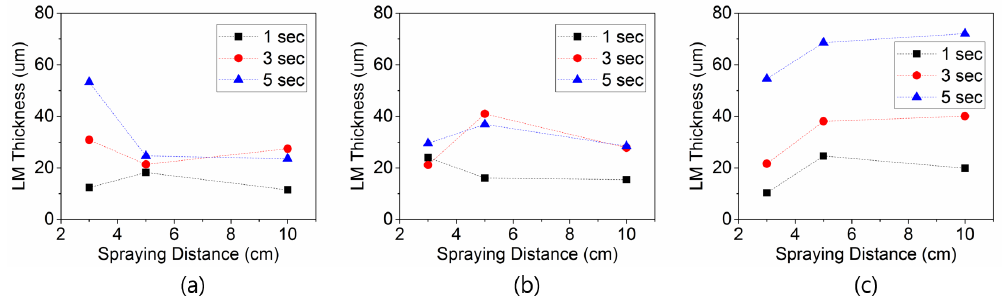
Figure 3. Characterization of sprayed LM line thickness when sprayed onto a substrate 3 cm, 5 cm, and 10 cm away from the nozzle for 1 s, 3 s, and 5 s. The spraying pressure is varied from ( a ) 100 kPa, ( b ) 150 kPa, and ( c ) 200 kPa.